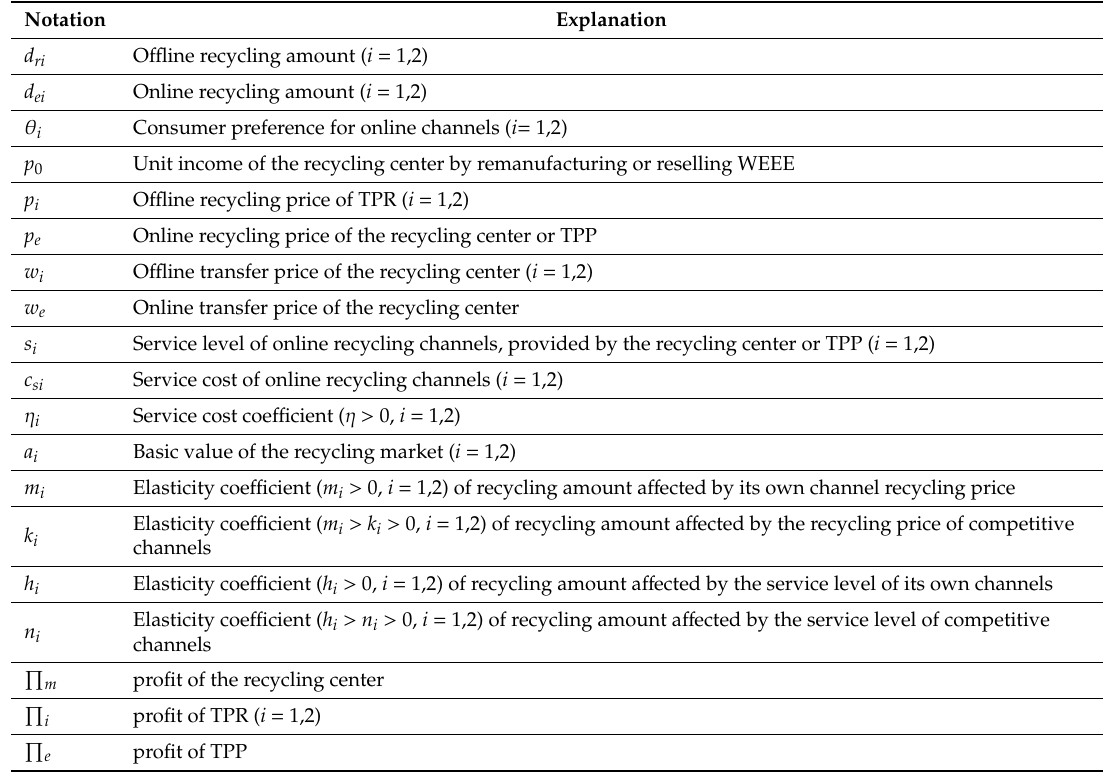
Table 1. Notation and explanations. WEEE, waste electrical and electronic equipment; TPR, third-party recycler; TPP, third-party